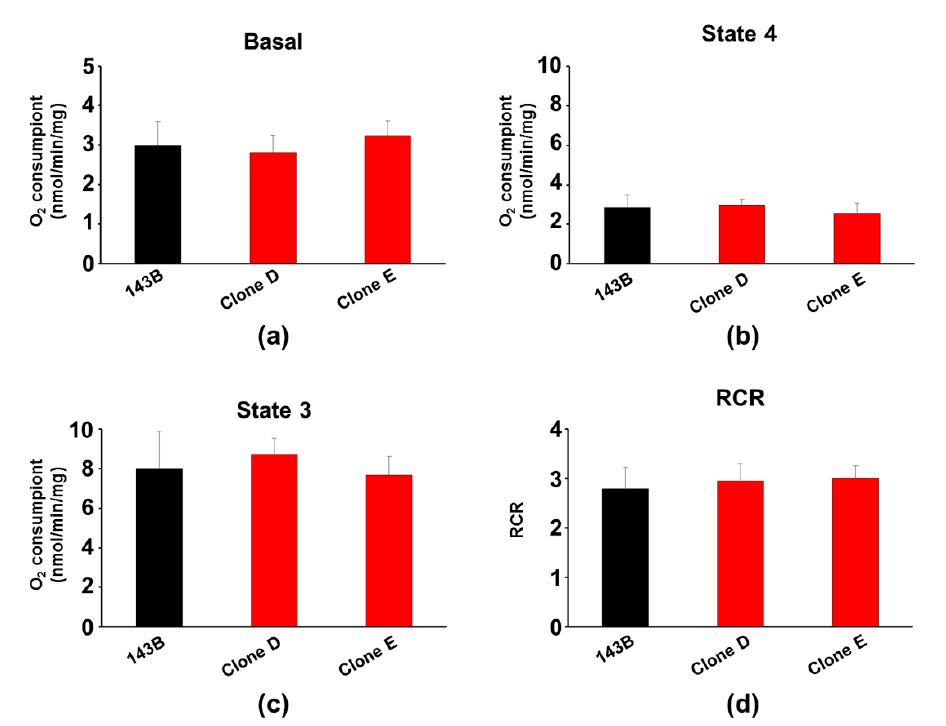
Figure 4. Oxygen consumption rate of 143B and mtRFP-expressing cells. Cell respiration of the parental 143B (black bar) and mtRFP-expressing cells (red bars) was assayed in intact cells ( a ) or in digitonin-permeabilized cells under both Complex I-driven state 4 ( b ) and state 3 ( c ) respiration rates, expressed as nmol O 2 / min / mg protein. From b and c, the respiratory control ratio (RCR) was calculated ( d ). Histograms show the mean ± SD of three different experiments.